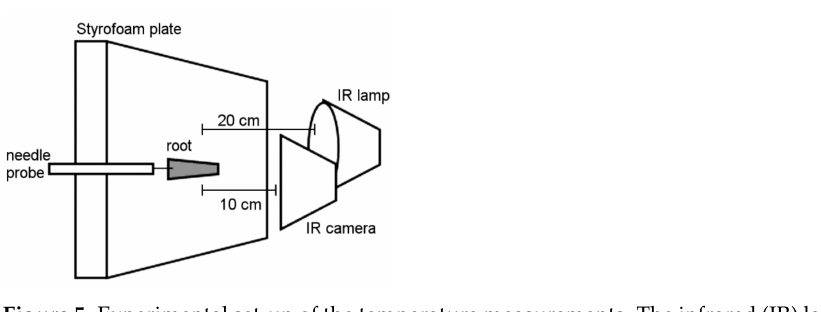
Figure 5. Experimental set-up of the temperature measurements. The infrared (IR) lamp was installed level with the test object at a 20 cm distance. The IR camera was installed level with the test object at a 10 cm